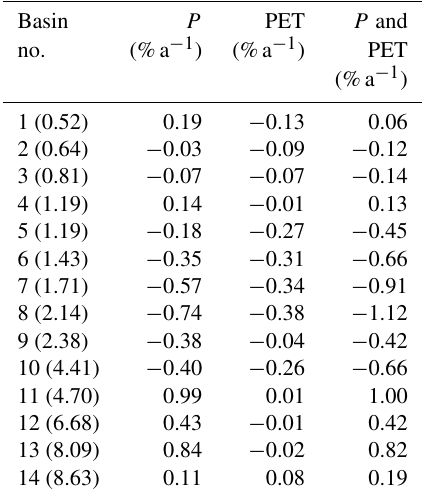
Table 3. The contributions of P , PET, and climate (i.e. P and PET) to R in the 14 basins of China for the period 1960–2008. The basin number is consistent with that given in Fig. 1. The numbers in the parentheses indicate the 1960–2008 mean aridity index.